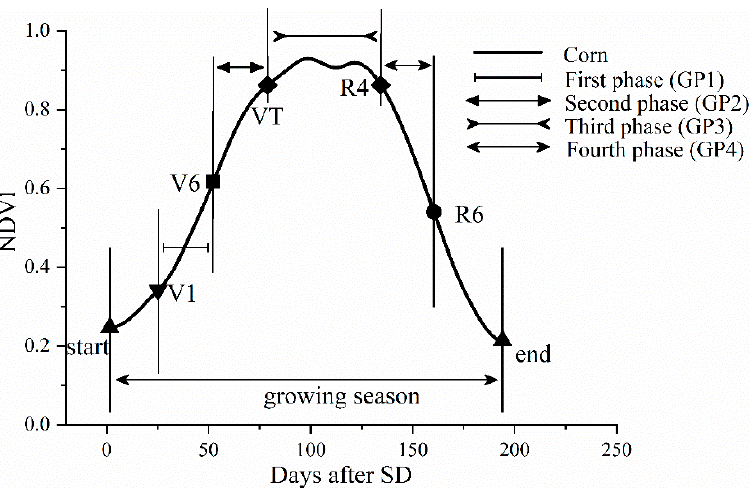
Figure 4. Schematic of the four growth phases for the county-level corn NDVI time series values of the growing season. SD denotes the start date of the corn-growing season.